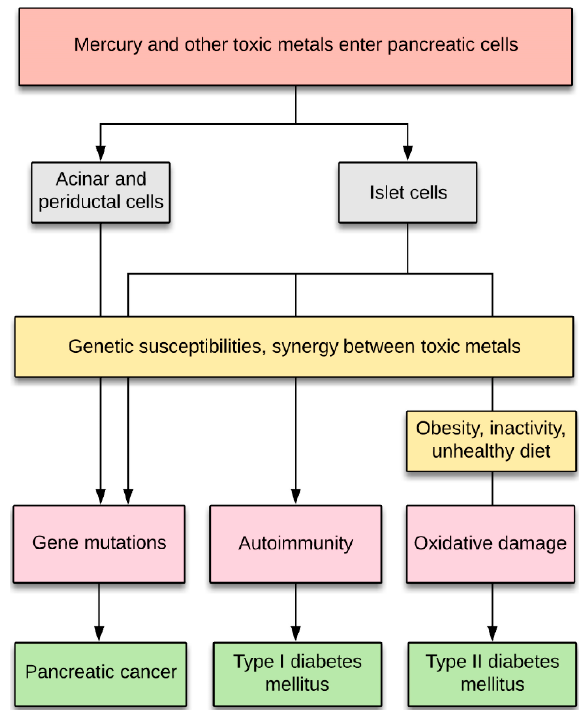
Figure 7. Potential contributions of toxic metals to pancreatic disorders. Exposures to toxic metals allow their entry into islet, acinar, and periductal cells. (1) Toxic metals could induce mutations in cells, aided by genetic susceptibility to metal toxicity and by synergistic effects between metals. (2) Toxic metals promoting autoimmunity in islet cells could precipitate type I diabetes mellitus in people with a genetic predisposition to immune overactivity. (3) Toxic metals causing oxidative stress could contribute to islet cell loss in type II diabetes mellitus.